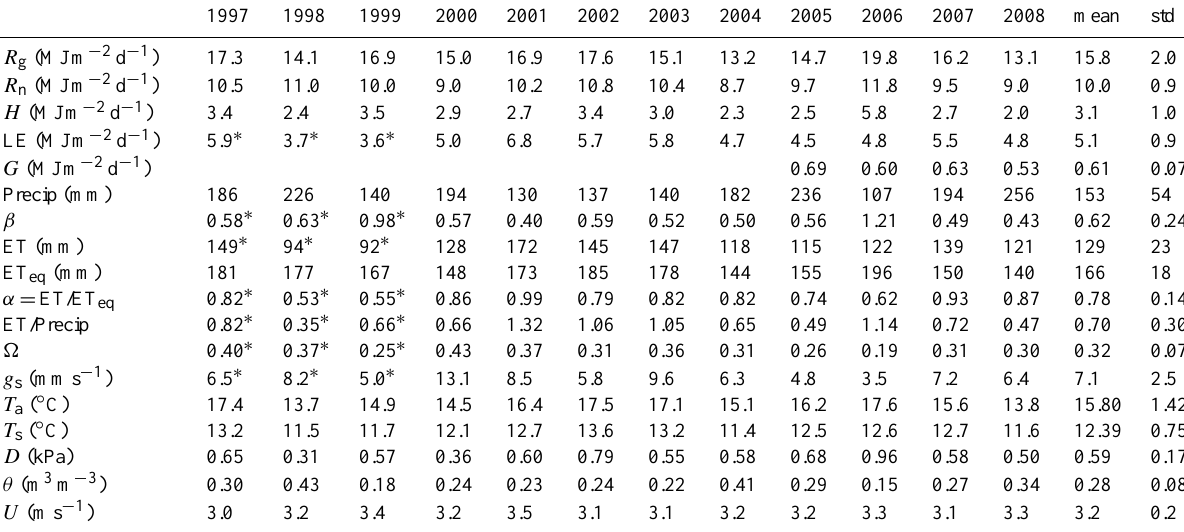
Table 2. As Table 1 but for July–August: R g and R n are global and net radiation, H , LE and G sensible, latent and soil heat fluxes, Precip and ET accumulated precipitation and evapotranspiration, ET eq the equilibrium evaporation (Eq. 6), β Bowen ratio ( H /LE), (cid:127) de-coupling coefficient (Eq. 5), g s surface conductance, T a and T s air and soil temperatures, D vapor pressure deficit, θ volumetric soil moisture content at 5–25cm depth and U mean wind speed. g s and (cid:127) correspond to daytime (08:00–20:00) conditions. Values marked with ∗ should be interpreted with care because the LE values in 1997–1999 are likely to be